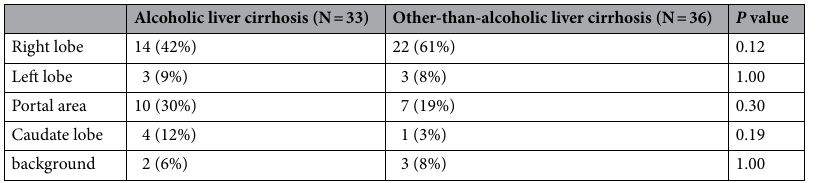
Table 3. Highlighted imaging regions according to gradient-weighted class activation maps (Grad-CAM). Results of the visual inspection of Grad-CAM images classified by ResNet50 are provided. Within each segmented image of the test set, highlighted regions were visually rated as being primary located within the right liver lobe, the left liver lobe, the portal area, the caudate lobe, or within image background by one radiologist experienced in abdominal imaging